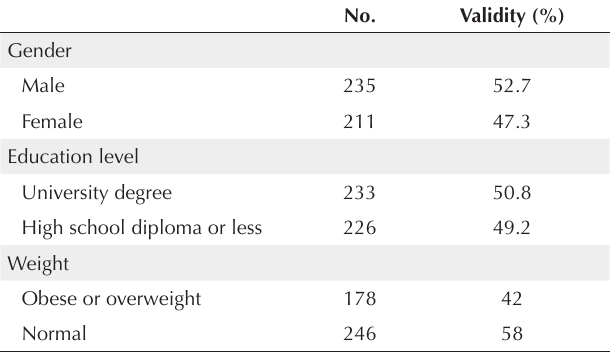
Table 2. Gender, Educational Level and Weight of Participants